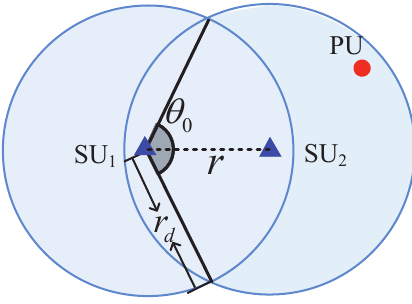
Figure 3. Detection region of a pair of